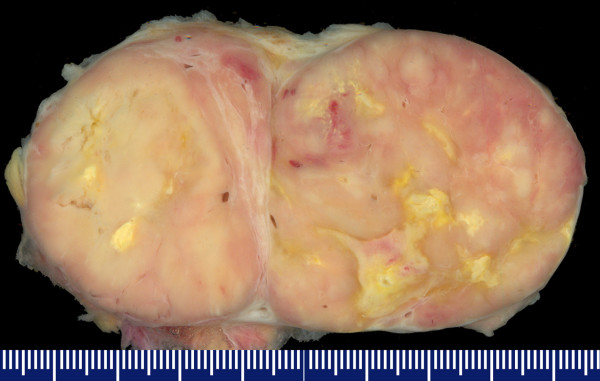
Macroscopic aspect of SFT. Macroscopic aspect of a solitary fibrous tumor: cut surface of a well circumscribed tumor; white to tan coloured cut surface with some deeply yellow necrotic areas (atypical/malignant solitary fibrous tumor, case 8).